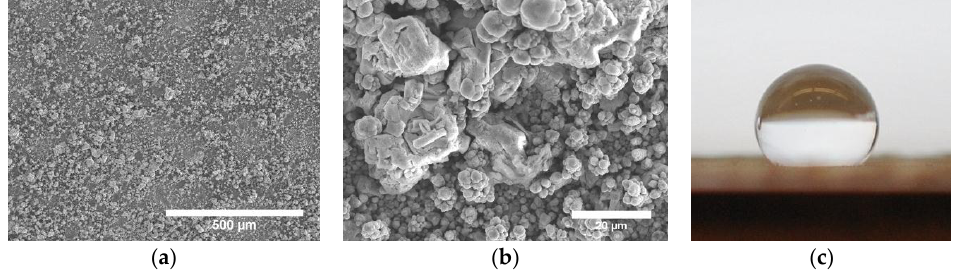
Figure 12. SEM micrographs of Ni-CeO 2 composite: ( a ) low magnification; ( b ) high magnification image showing aggregates of micron-sized CeO 2 particles and Ni matrix with a cauliflower-like structure; ( c ) a 5-µL water droplet at rest on a Ni-58 vol % CeO 2 composite coating. Contact angle = 140°.